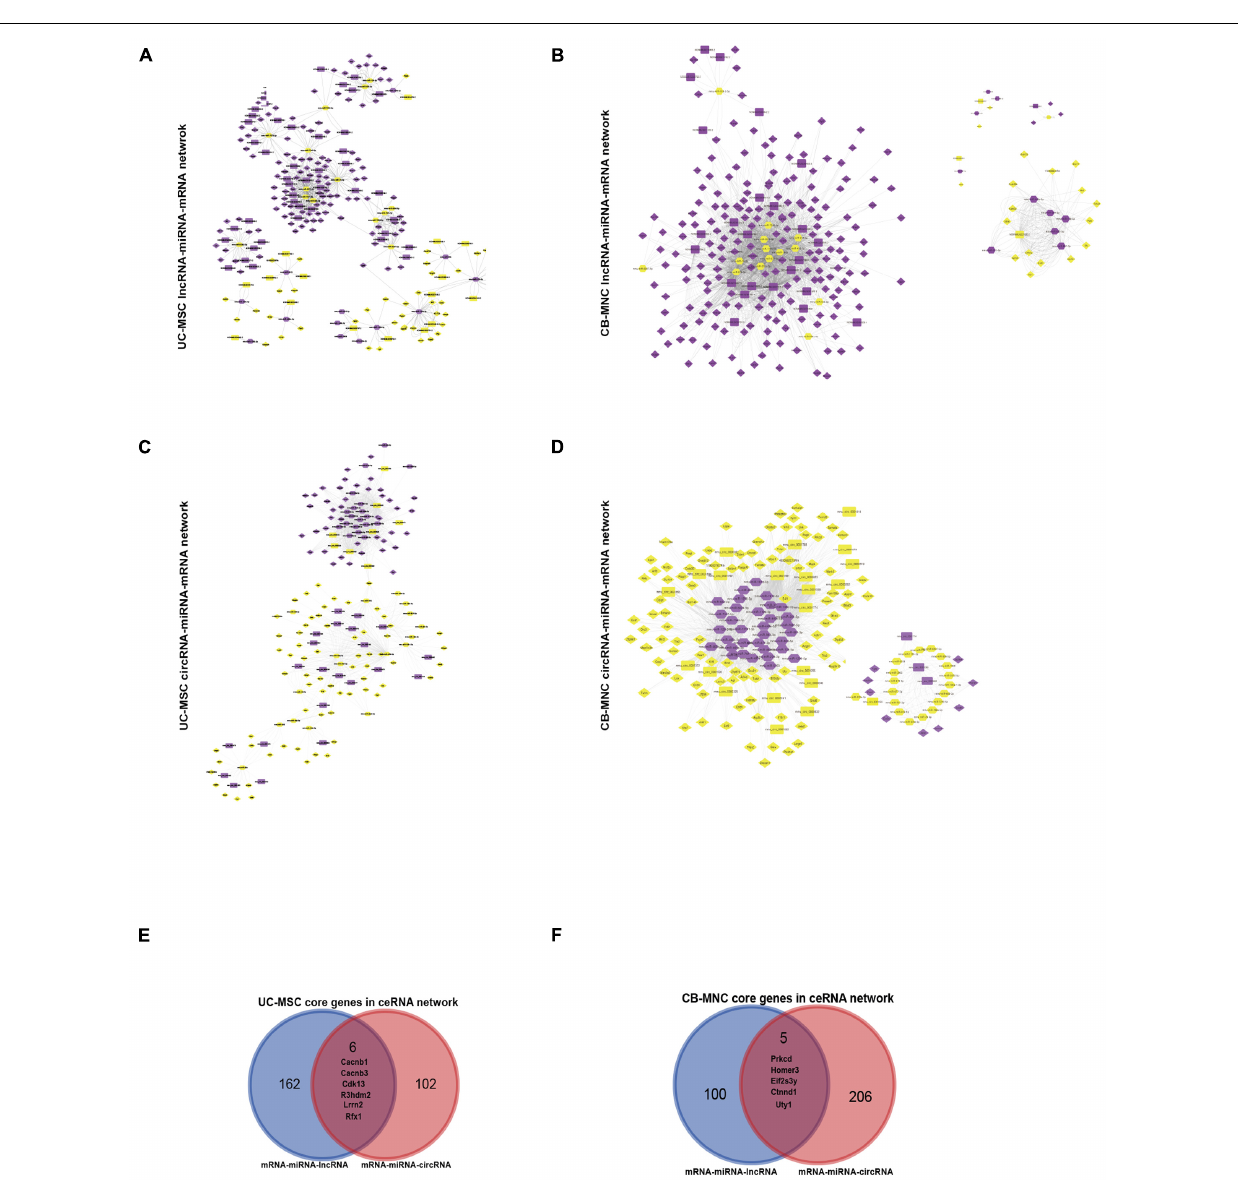
FIGURE 9 | Construction of dysregulated mRNA–lncRNA coexpression network (DMLCN) and the dysregulated mRNA–circRNA coexpression network (DMCCN) based on the correlation value. (A,B) The layout of dysregulated mRNA–lncRNA ceRNA network (DMLCN). A total of 239 nodes and 602 edges were identified in umbilical cord-derived mesenchymal stem cell (UC-MSC)-infused groups relative to bronchopulmonary dysplasia (BPD) mice, and a total of 264 nodes and 2,138 edges were identified in cord blood-derived mononuclear cell (CB-MNC)-infused groups relative to BPD mice. Purple diamond: upregulated mRNAs, yellow diamond: downregulated mRNAs; purple hexagon: upregulated miRNA, yellow hexagon: downregulated miRNA; purple round rectangle: upregulated lncRNAs, yellow round rectangle: downregulated lncRNAs. (C,D) The layout of dysregulated mRNA–circRNA ceRNA network (DMCCN). A total of 177 nodes and 1,326 edges were identified in UC-MSC-infused groups relative to BPD mice, and a total of 182 nodes and 1,942 edges were identified in CB-MNC-infused groups relative to BPD mice. Purple diamond: upregulated mRNAs, yellow diamond: downregulated mRNAs; purple round rectangle: upregulated circRNAs, yellow round rectangle: downregulated circRNAs. (E) The Venn diagram could demonstrate that six key genes were contained in the mRNA–miRNA–lncRNA and mRNA–miRNA–circRNA ceRNA network of UC-MSC-infused group simultaneously. (F) The Venn diagram could demonstrate that five genes were contained in the mRNA–miRNA–lncRNA and mRNA–miRNA–circRNA ceRNA network